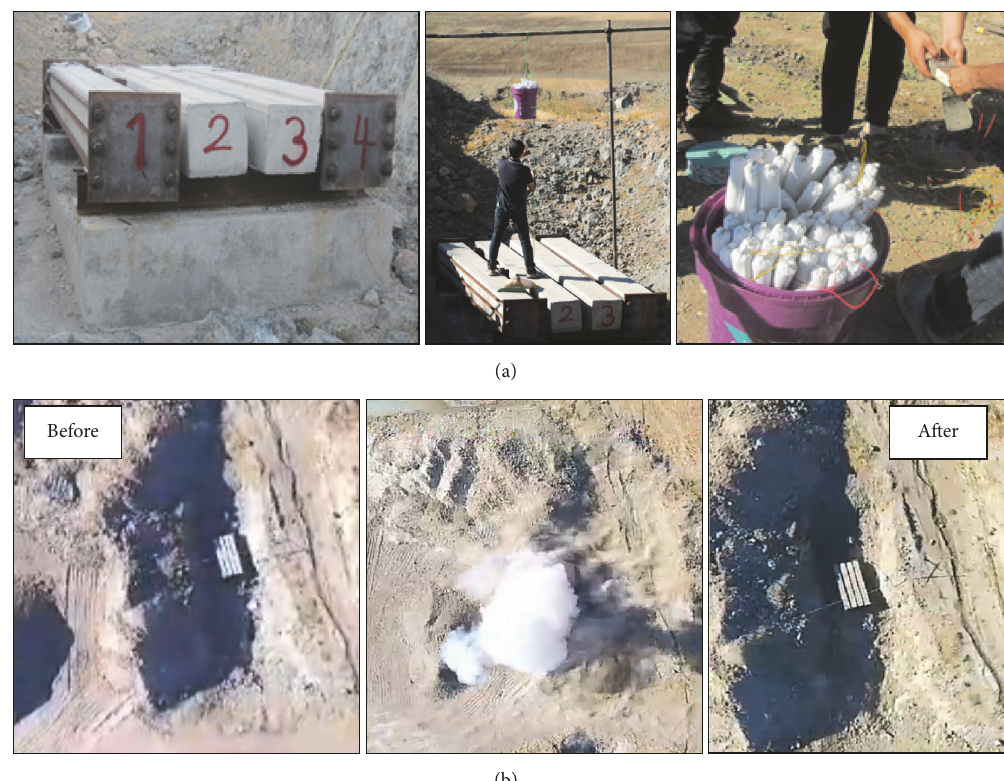
Figure 7: Test setup for blast loading of the specimen (a) and aerial photos of the explosion event